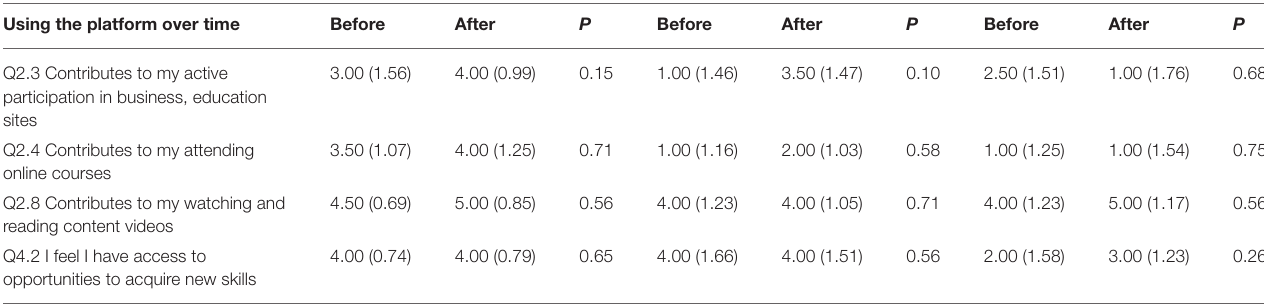
TABLE 8 | Descriptive statistics (median and standard deviation) for answers to the education digital indicator questions and comparison using Wilcoxon non-parametric statistical test. Using the platform over time Before After P Before